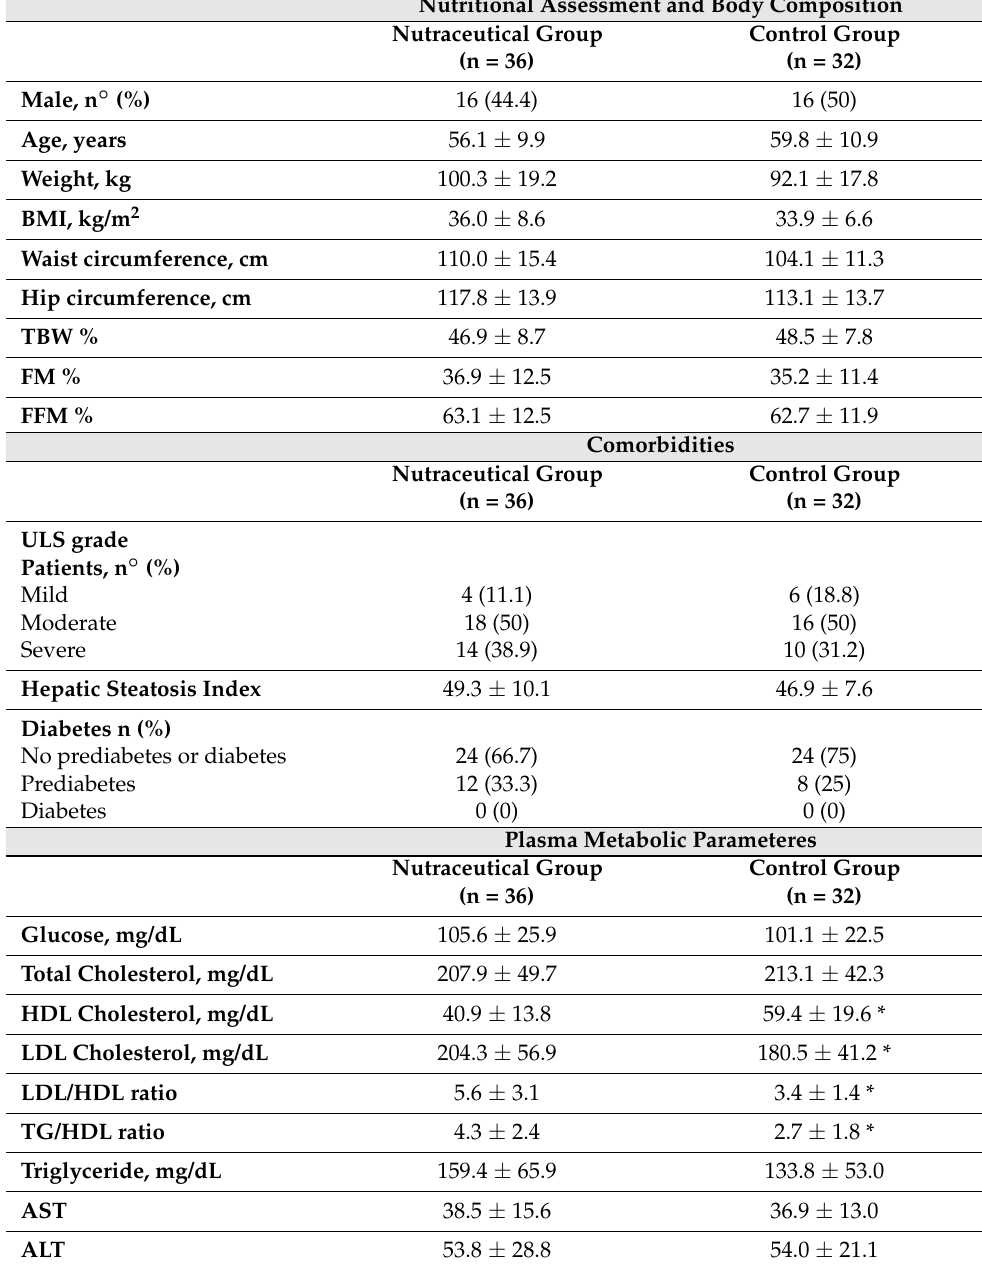
Table 2. Baseline clinical characteristics of participants. Data are reported as mean ± DS. * p < 0.05 vs. Nutraceutical group. Nutritional Assessment and Body